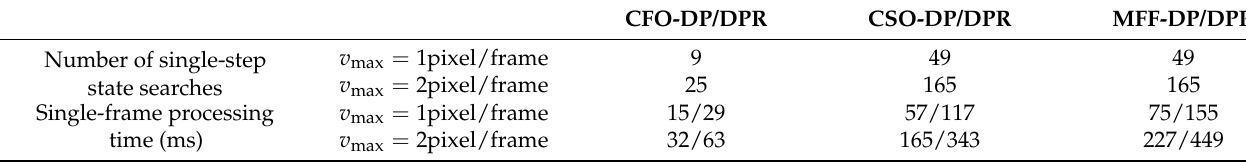
Table 1. Comparison of the computational efficiencies of the DP/DPR algorithms in single-target